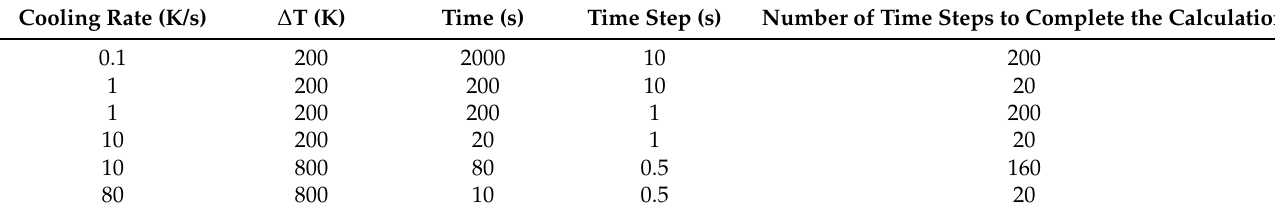
Table 2. Time distribution for the different areas of rate analysis.